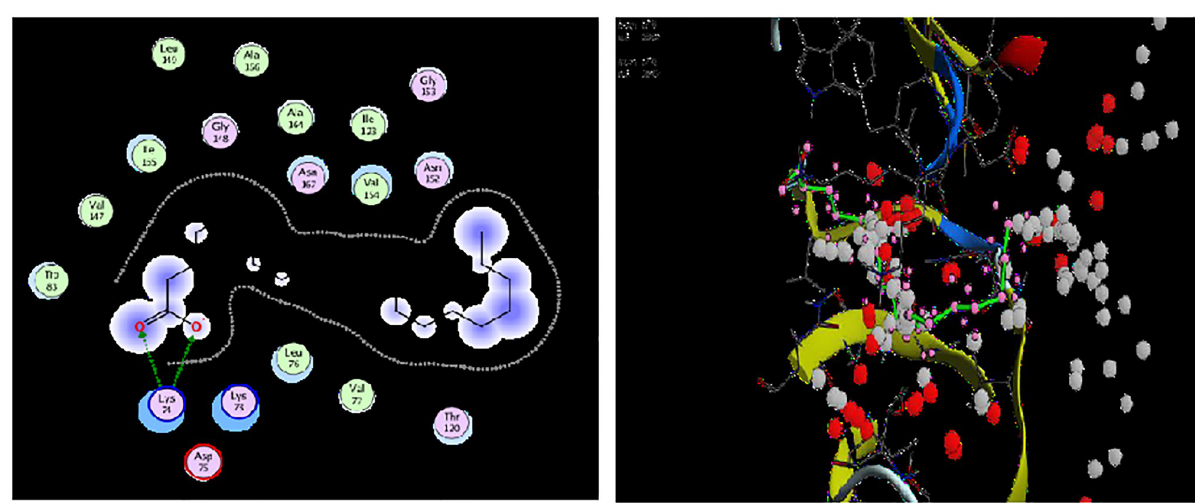
Fig 7. 2D and 3D interaction of compound (1, 2-Benzenedicarboxylic acid) with the target protein (PDB ID: 2FOM).